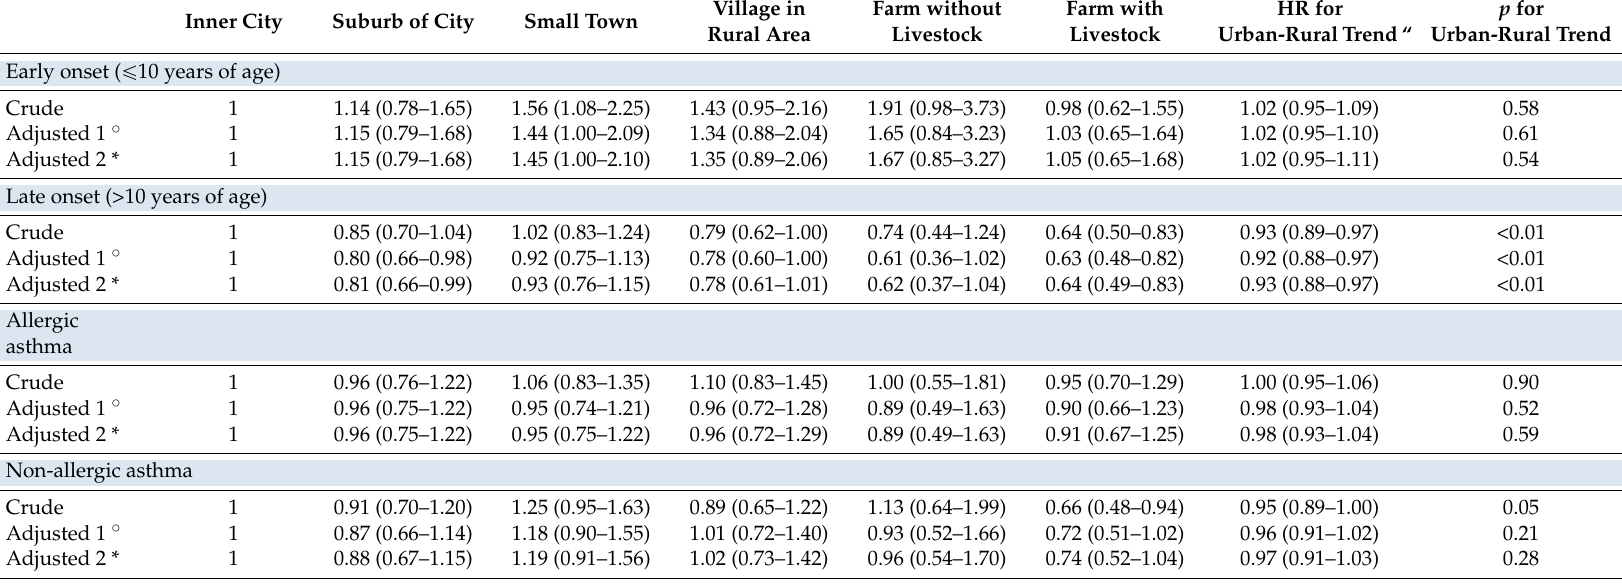
Table 4. Cox regression analyses on asthma phenotypes presented as HR (95% CI). Allergic asthma was defined as presence of both hay fever and asthma. Inner City Suburb of City Small Town